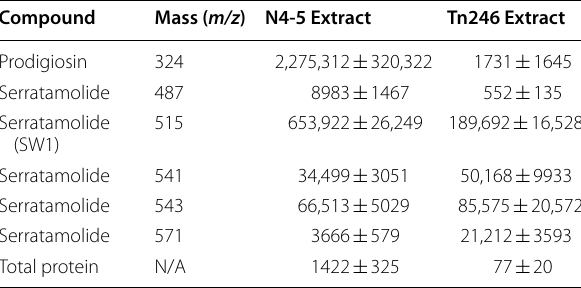
Table 1 Compounds identified in ethanol extracts of Serratia marcescens strains N4-5 and Tn246